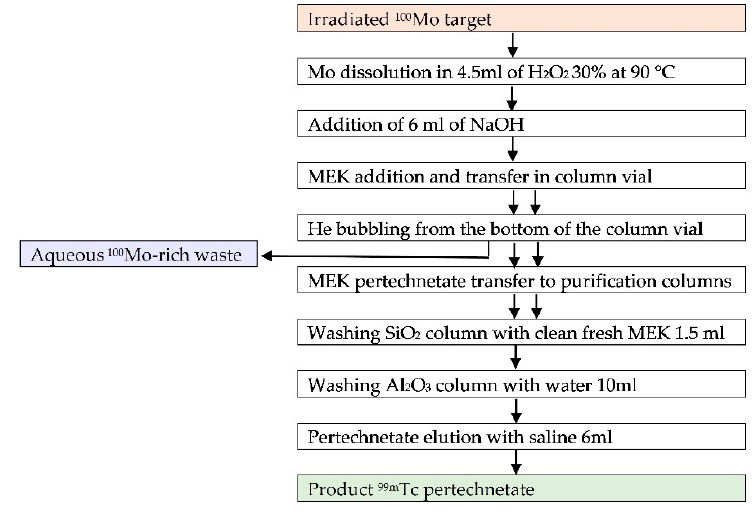
Figure 2. Target processing and 100 Mo/ 99m Tc separation–purification protocol.